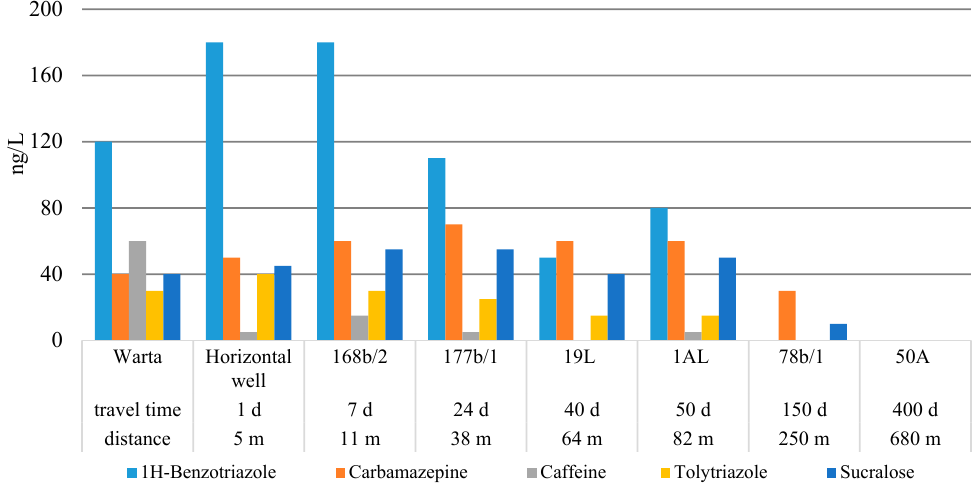
Figure 7. Changes in the detected micropollutant concentrations along the flow path.